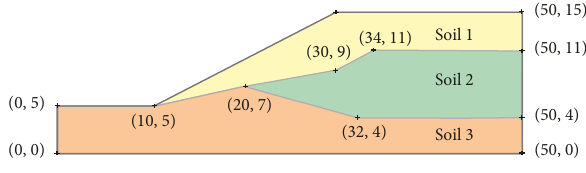
Figure 7: Geometry of the slope of Example 3. Table 9: Properties of stochastic variables of Example 3.